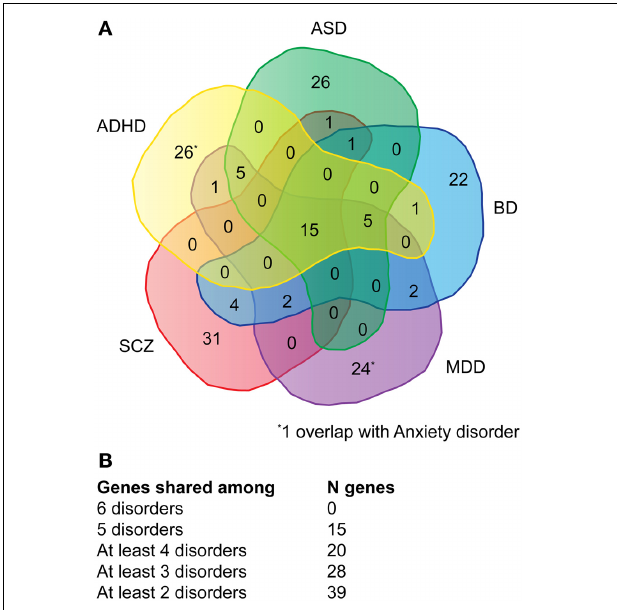
FIGURE 1 | Venn diagram depicting the overlap of genes across multiple disorders. (A) For each disorder (ADHD, ASD, BD, MDD, SCZ) the overlap of top-51 SNPs with associated protein-coding genes is depicted. For anxiety only 16 protein-coding genes could be retrieved, one overlaps with ADHD and one with MDD. (B) Summary of the number of genes shared among disorder. A detailed list of genes can be viewed in Supplementary Table